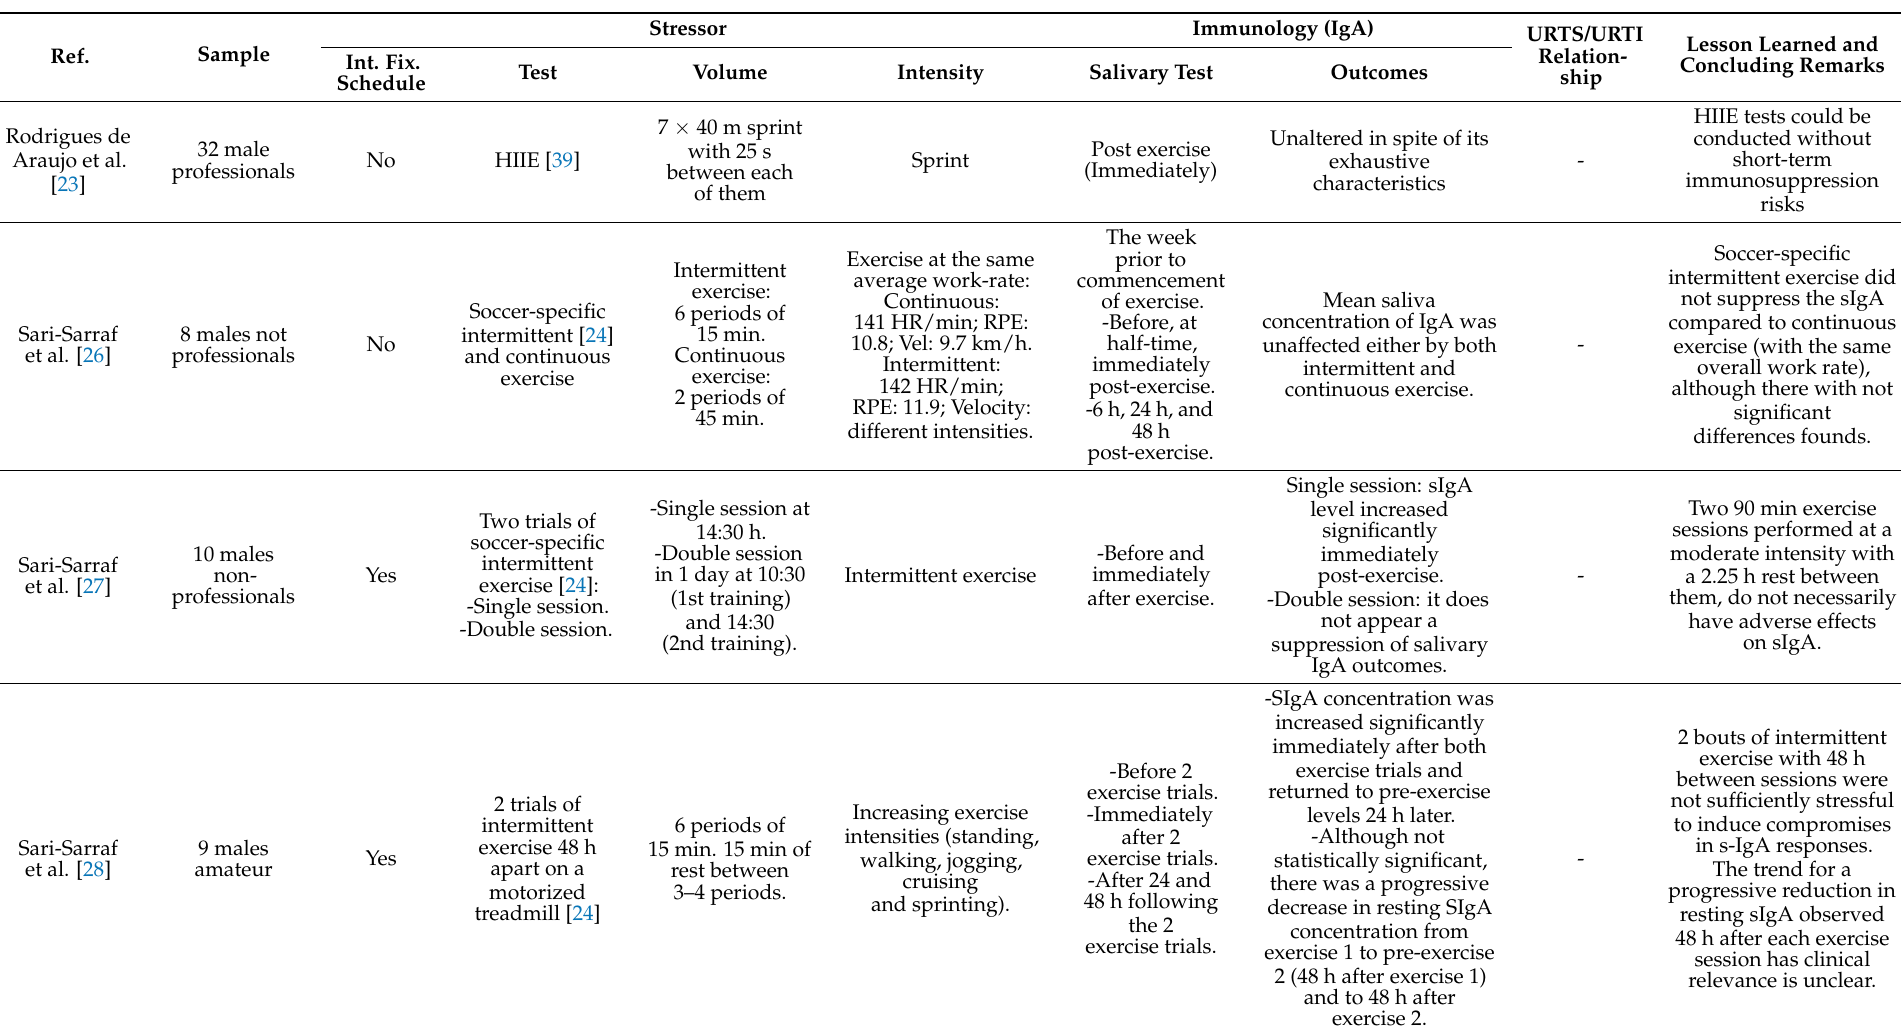
Table 2. Immunoglobulin A (IgA) responses considering repeated sprint ability and treadmill exercises as a stressor during intensive or non-intensive fixture schedules.